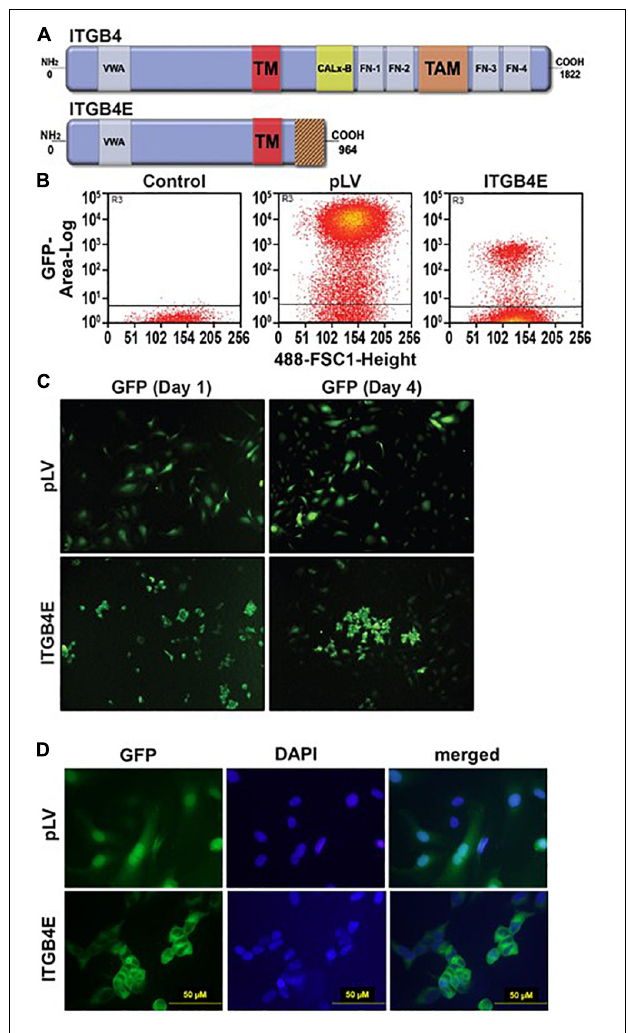
FIGURE 2 | Overexpression of ITBG4E in human lung ECs. (A) ITGB4E structure. While full-length ITGB4 is characterized by a 1,000 amino acid cytoplasmic tail, ITGB4E has a unique, truncated 114 amino acid cytoplasmic domain (TM, transmembrane domain; PSI, plexin-semaphorin-integrin domain; VWA, von Willebrand factor A domain; TM, transmembrane domain; FN, fibronectin type III domain; TAM, tyrosine activation motif). (B) Human pulmonary artery ECs were transfected with ITBG4E-GFP or control vector (pLV-GFP) with green fluorescent protein (GFP)-positive cells sorted using flow cytometry. (C) Transfected cells were cultured and imaged on days 0 and 4. (D) Separately, 4 (cid:48) ,6-diamidino-2-phenylindole (DAPI) staining on day 4 was performed as well (representative images